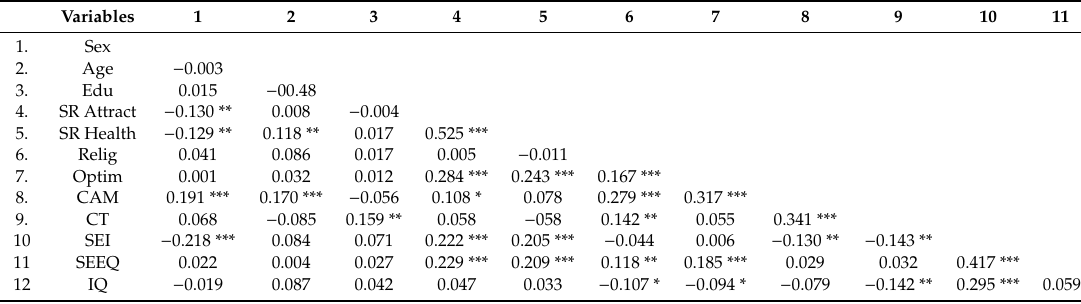
Table 2. Pearson product-moment correlations of variables in the second